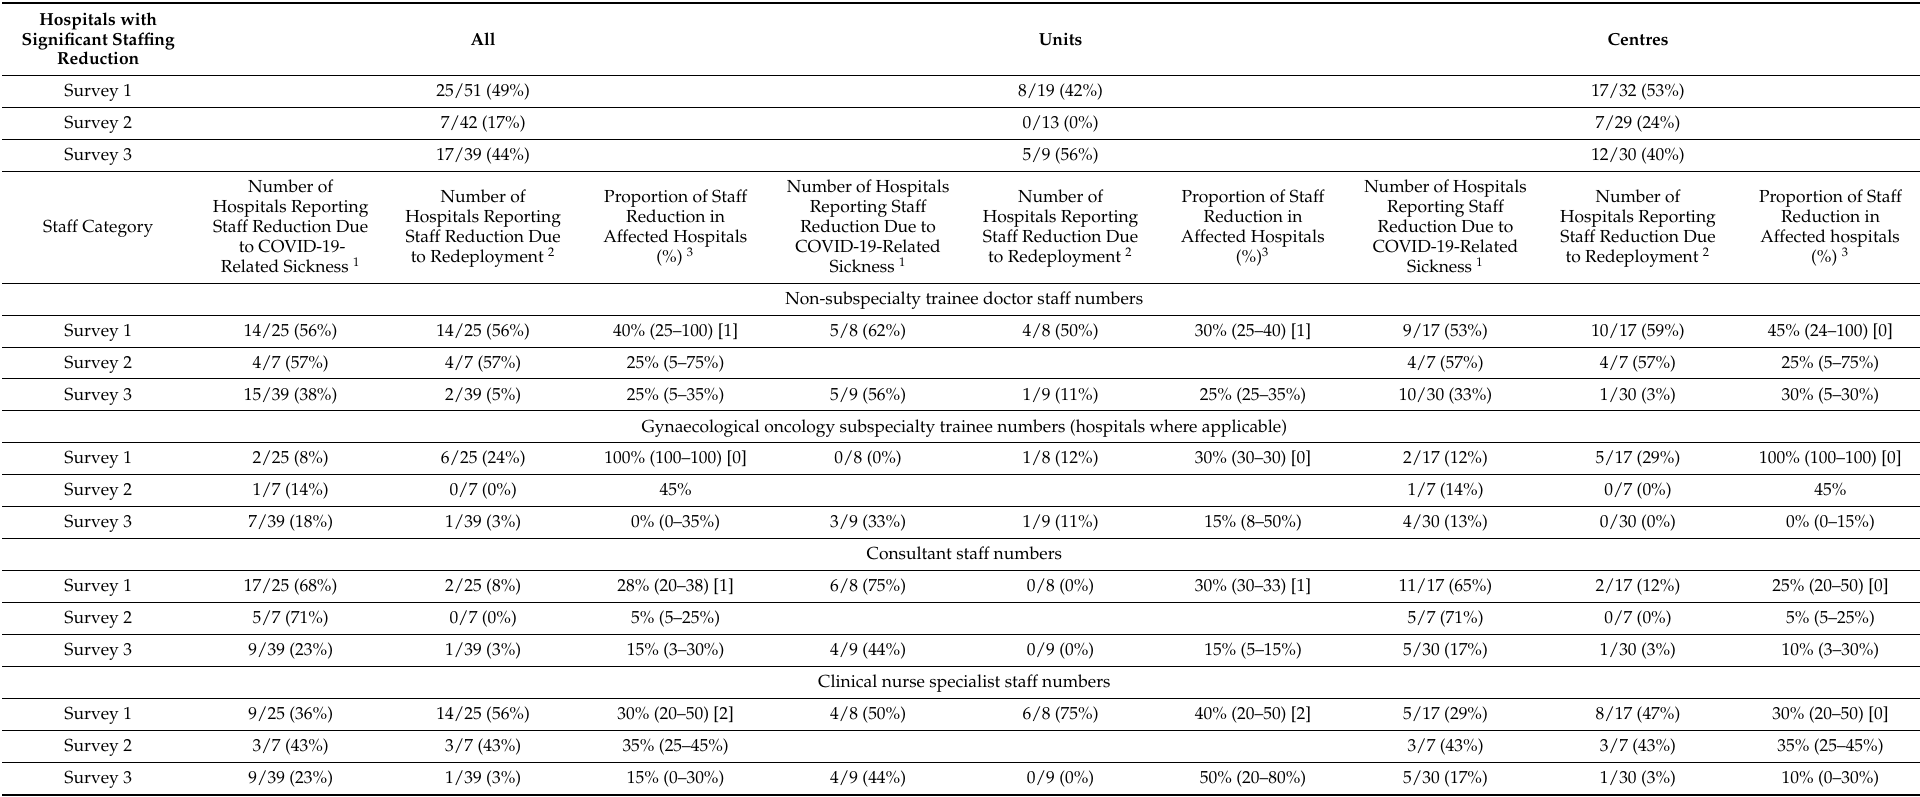
Table 1. Reduction in staff in